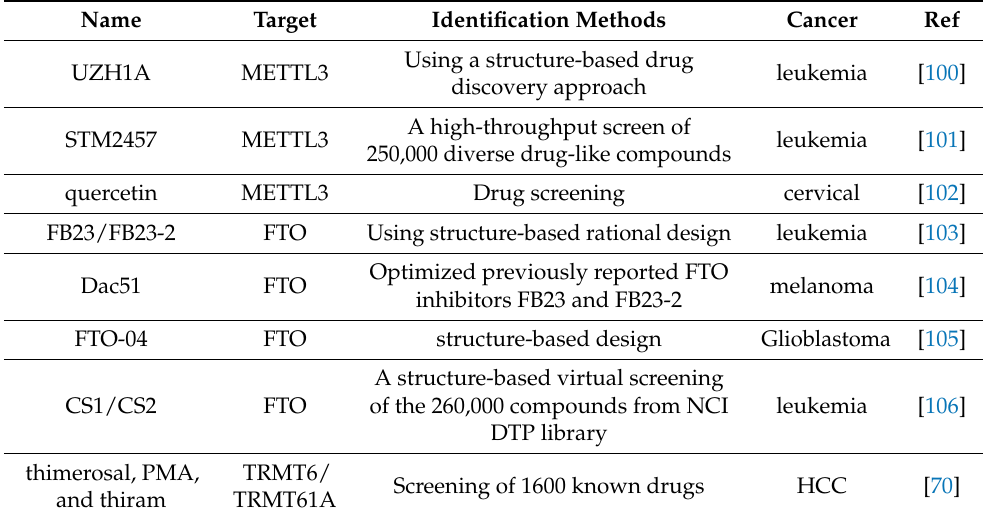
Table 4. Inhibitors of RNA modification